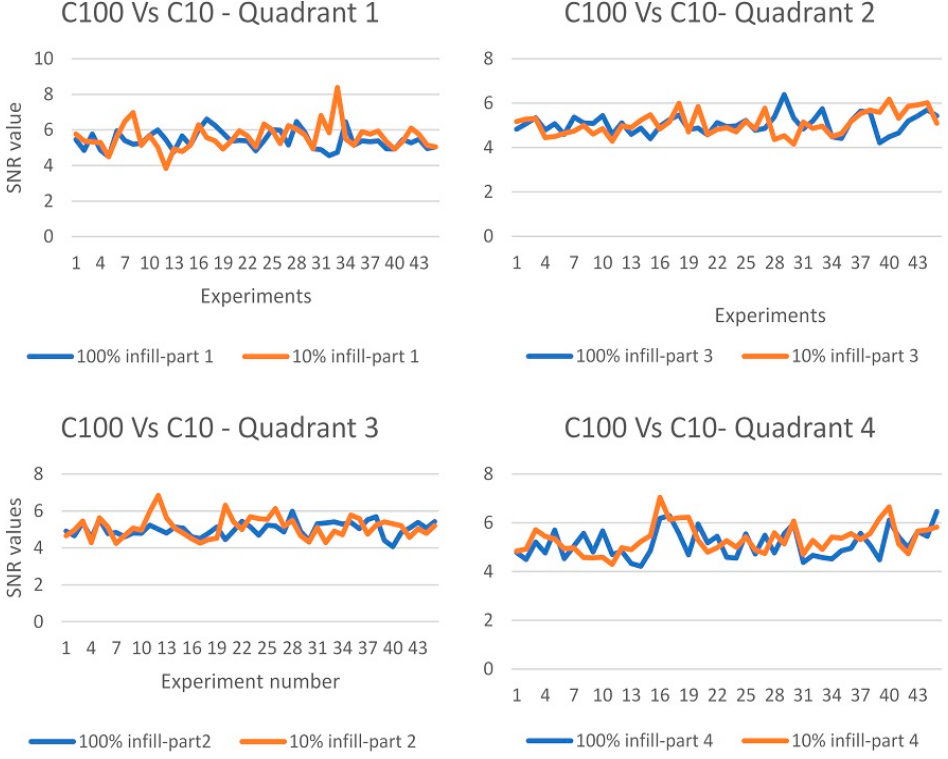
Figure 7. SNR comparison between the C10 and C100 samples.